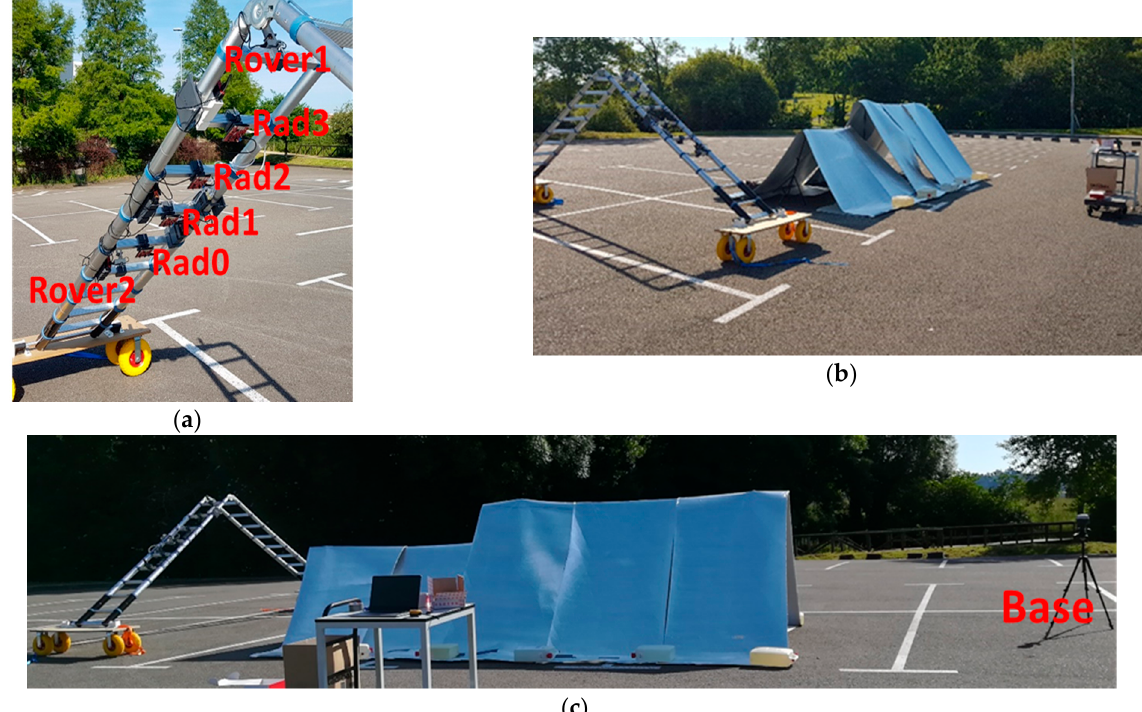
Figure 4. ( a ) Scheme of the sensors arrangement on the ladder; ( b ) lateral and ( c ) front views of the stockpile-alike model.